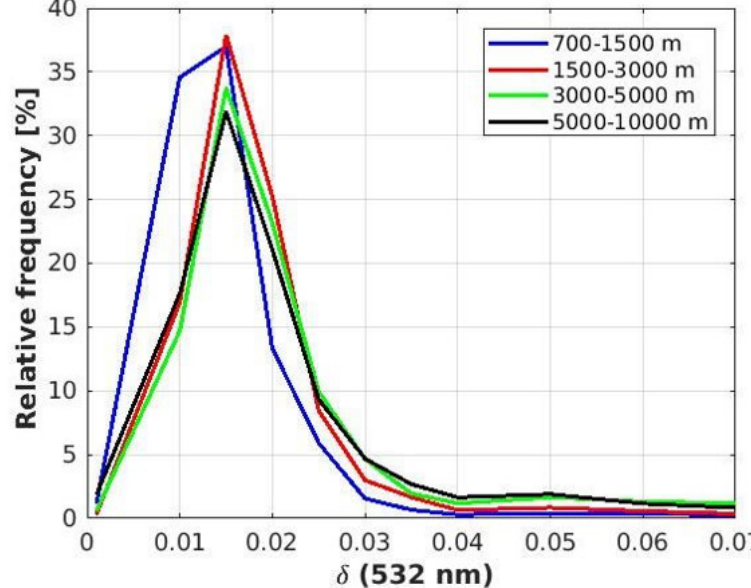
Figure 6. January–April: Frequency of δ 532 .